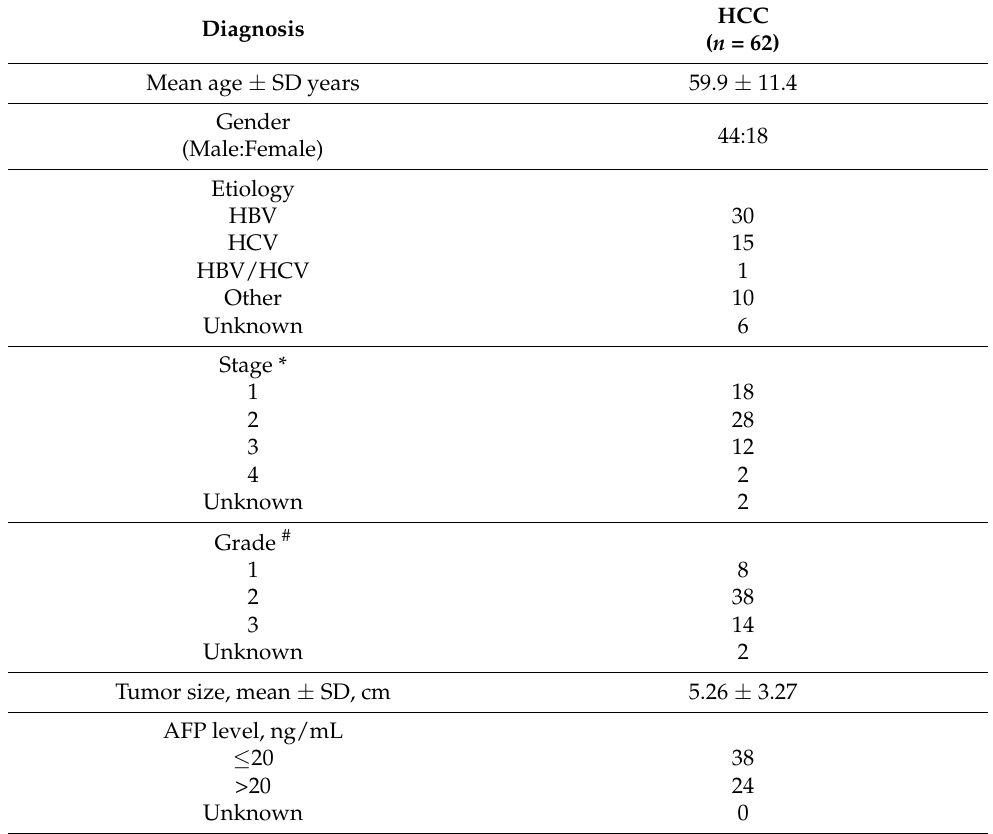
Table 2. Clinicopathological characteristics of the cohort 2 patient urine samples analyzed in this